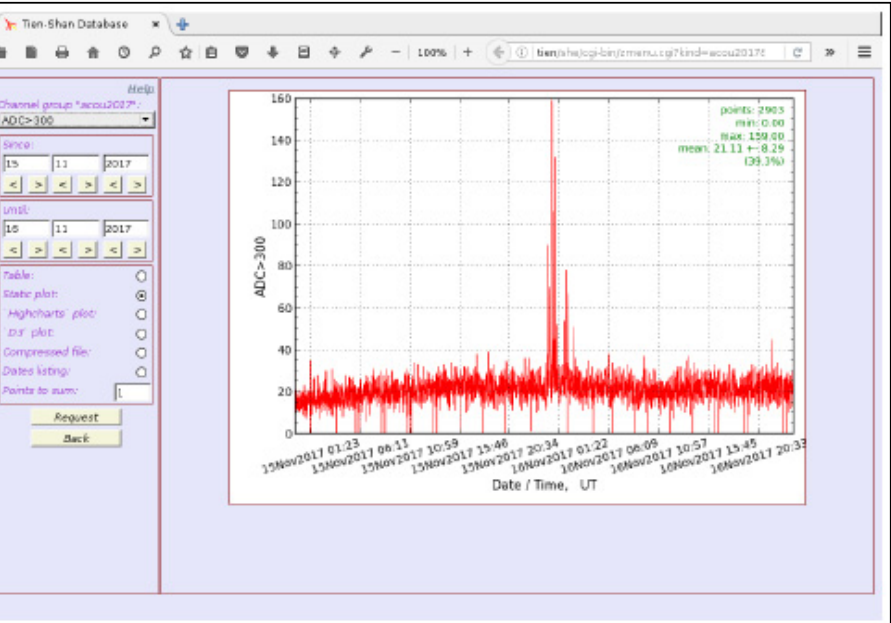
Figure 7. Results of long-term measurements with an acoustic detector presented on the web page of Tien Shan station: amplitudes of recorded acoustic pulses exceeding 300 code.